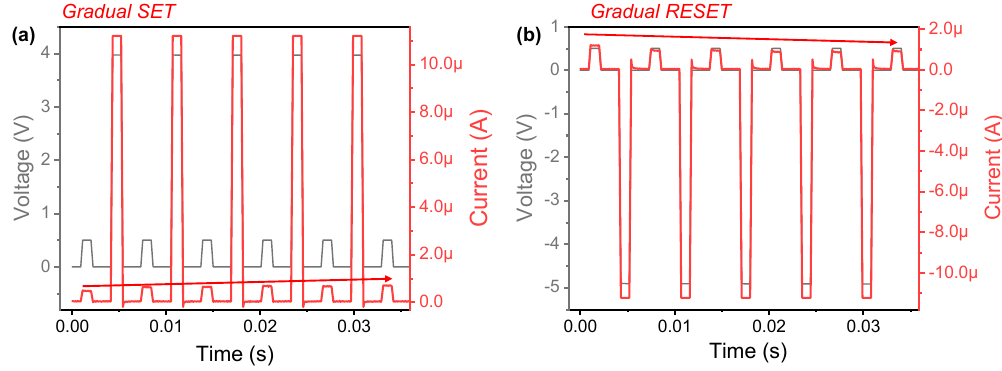
Figure 4. I – V characteristics of Ag/TiO 2 /ZrN/Si device. ( a ) Bipolar resistive switching with gradual SET and RESET processes, forming a curve in the left inset, and endurance cycle in right inset. ( b ) Failure in the working of unipolar switching.